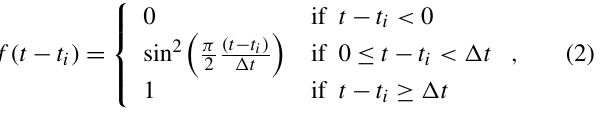
Figure 4 quantifies the effects of the nudging on the zonal- mean winds and meridional heat fluxes in free , nudged , and control ensemble forecasts from the CESM2 model.